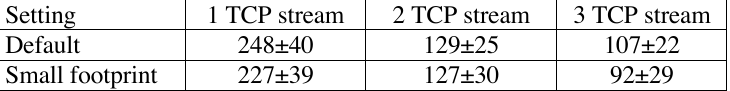
Table 1 . Performance comparison with multiple TCP streams